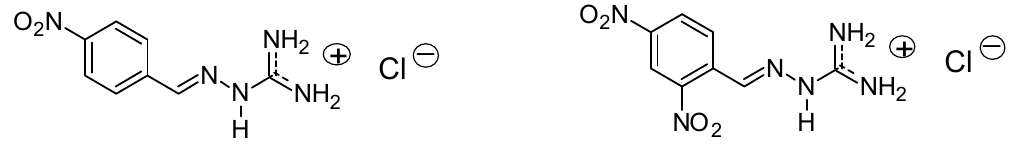
Figure 1. Structures of guanylhydrazones capable of inhibiting acetylcholinesterase (AChE) reported by Petronilho et al. [13].